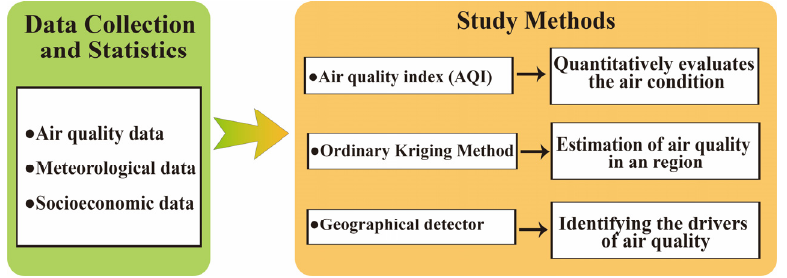
Figure 2. Roadmap of methods.